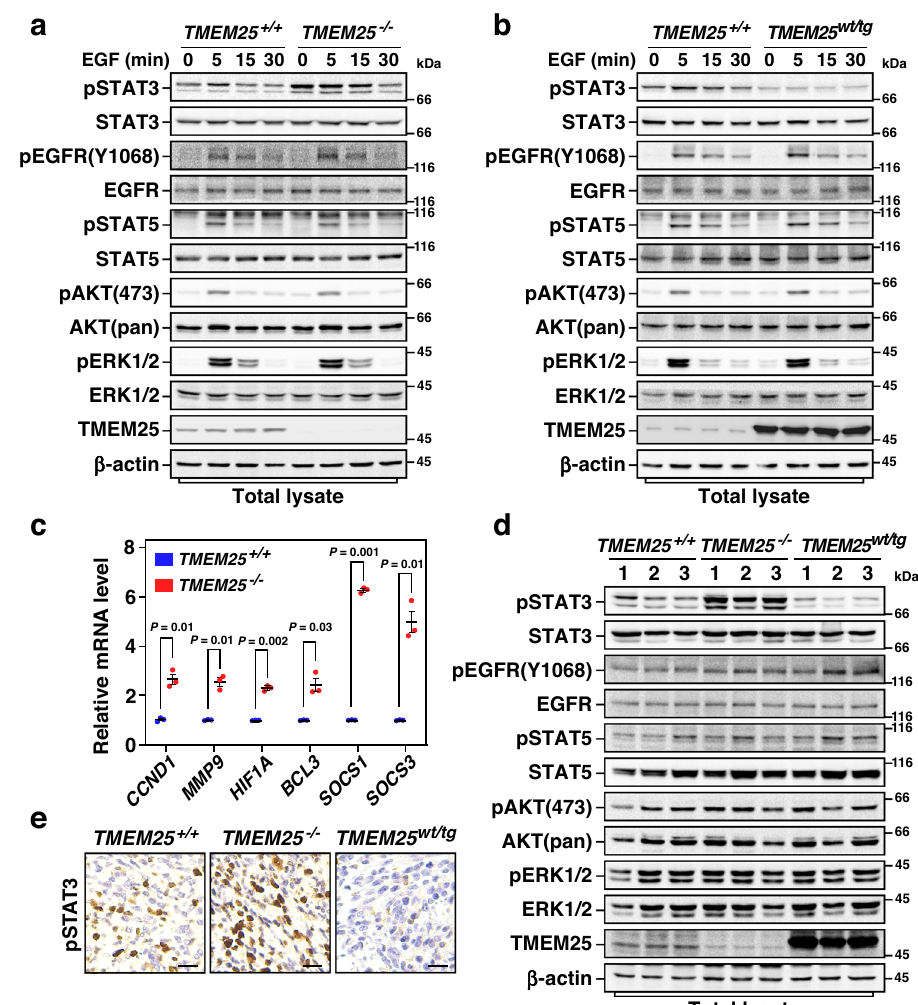
Fig. 3 | TMEM25 negatively regulates STAT3 signaling. a Knockout of TMEM25 induces phosphorylation of STAT3 in MEF cells. Primary MEF cells derived from TMEM25 +/+ or TMEM25 − / − micewereserum-starvedovernightandthentreatedwith 100ng/ml EGF for the indicated time before subjected to immunoblotting assay. b Overexpression of TMEM25 inhibits EGF treatment-induced phosphorylation of STAT3inMEFcells.PrimaryMEFcellsderivedfrom TMEM25 +/+ or TMEM25 wt/tg mice were treated and analyzed as in ( a ). c Knockout of TMEM25 increases mRNA levels of representative STAT3 target genes. The mRNA levels of indicated genes in TMEM25 +/+ or TMEM25 − / − MDA-MB-231 cells were measured by real-time